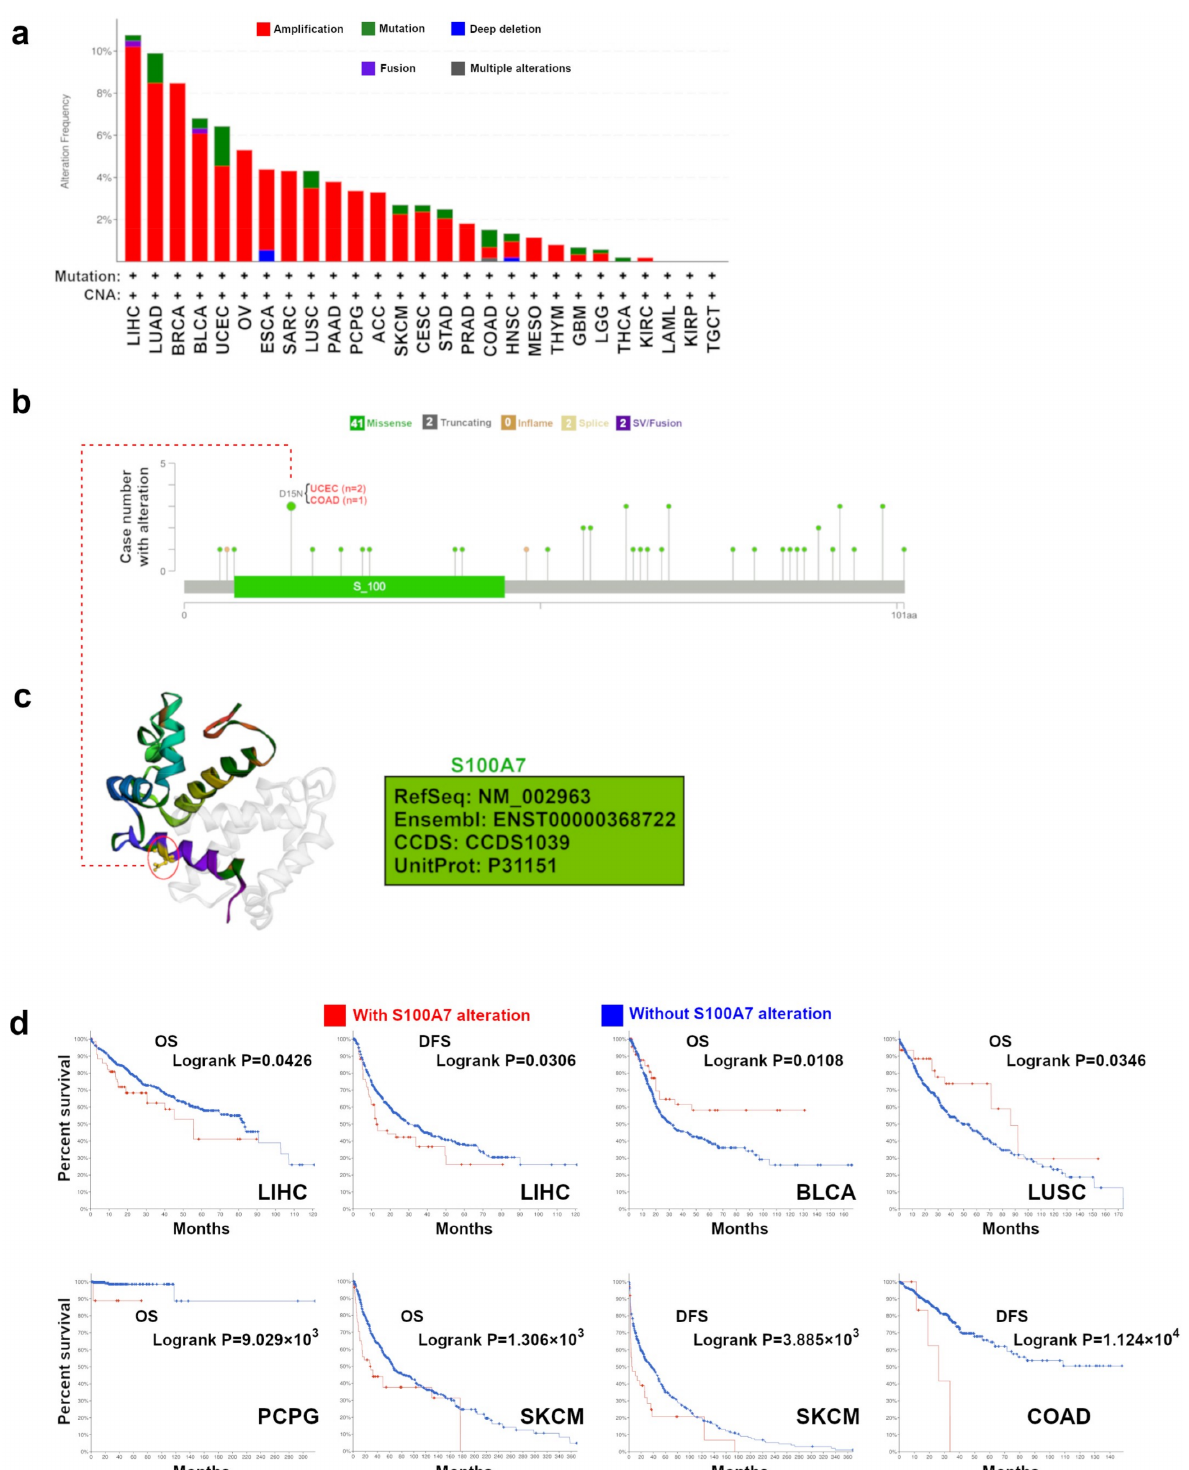
Figure 3. Mutation feature of S100A7 in different tumors of TCGA. ( a ) The alteration frequency with mutation type of S100A7 for the tumors in TCGA project. ( b ) The mutation sites of S100A7 in TCGA tumors are displayed. ( c ) The mutation site with the highest alteration frequency (D15N) in the 3D structure of S100A7. ( d ) The potential correlation between the mutation status of S100A7 and overall (OS), progression-free (PFS), disease-specific (DSS) and disease-free survival (DFS) of